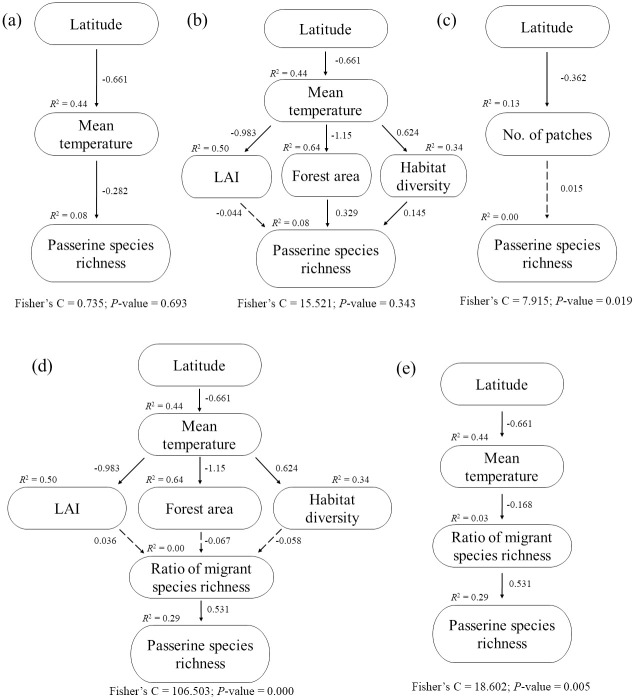
The key piecewise structural equation models (pSEM) for testing the hypotheses of peninsular effect based on recent deterministic ((a) and (b)), anthropogenic (c), and stochastic ((d) and (e)) processes.Solid arrows represent significant paths (P < 0.05) while dashed arrows represent nonsignificant paths (P > 0.05). For each variable, R2 is provided. Model-fit statistics (Fisher’s C and P-value) for each pSEM are given.